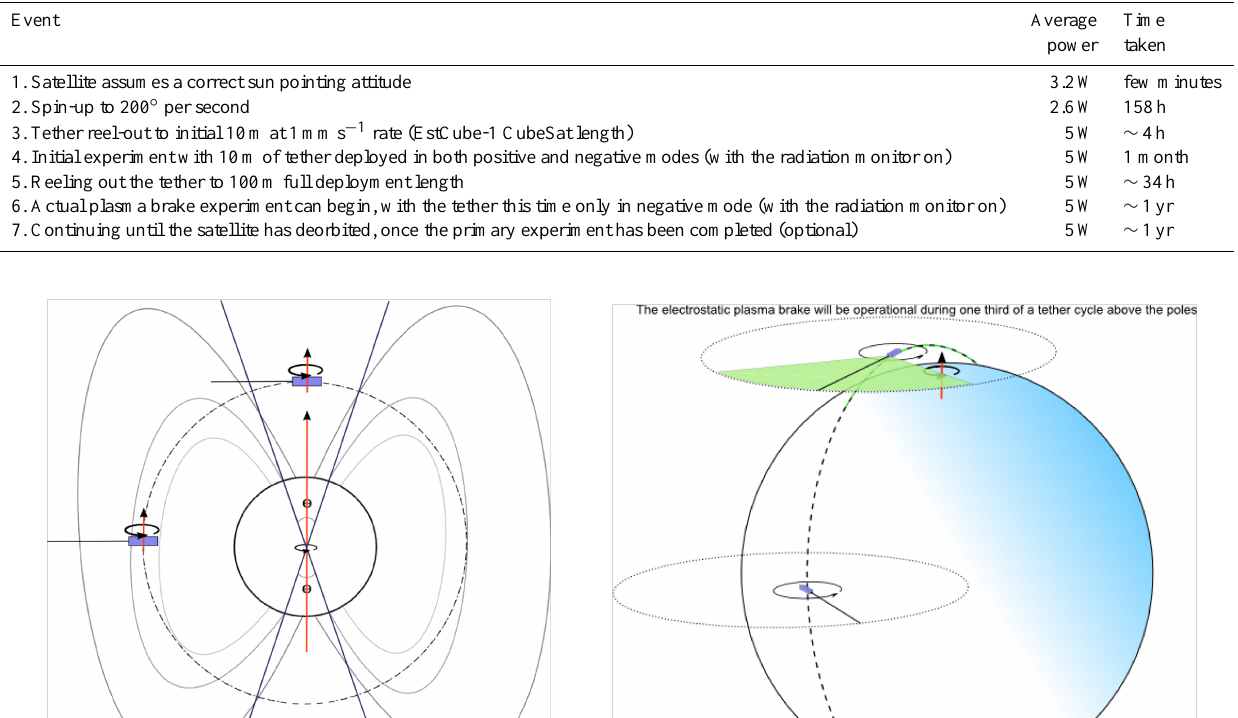
Table 1. The electrostatic plasma brake demonstration phase steps.